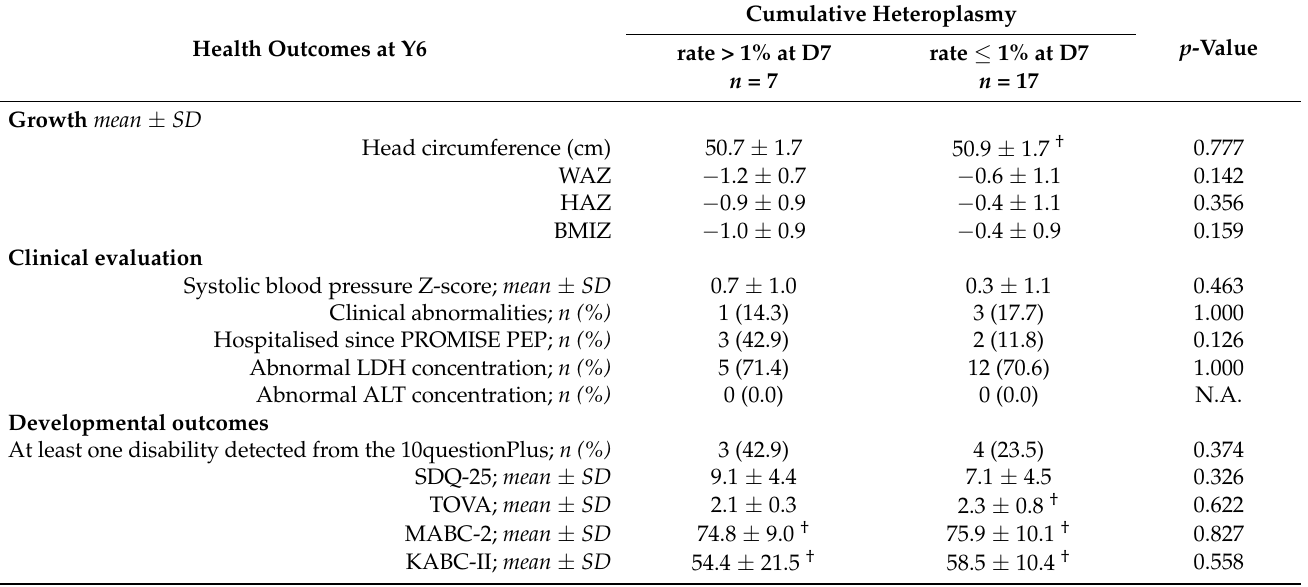
Table 5. Association between having a heteroplasmy rate >1% at D7 and health outcomes at Y6. Health Outcomes at Y6